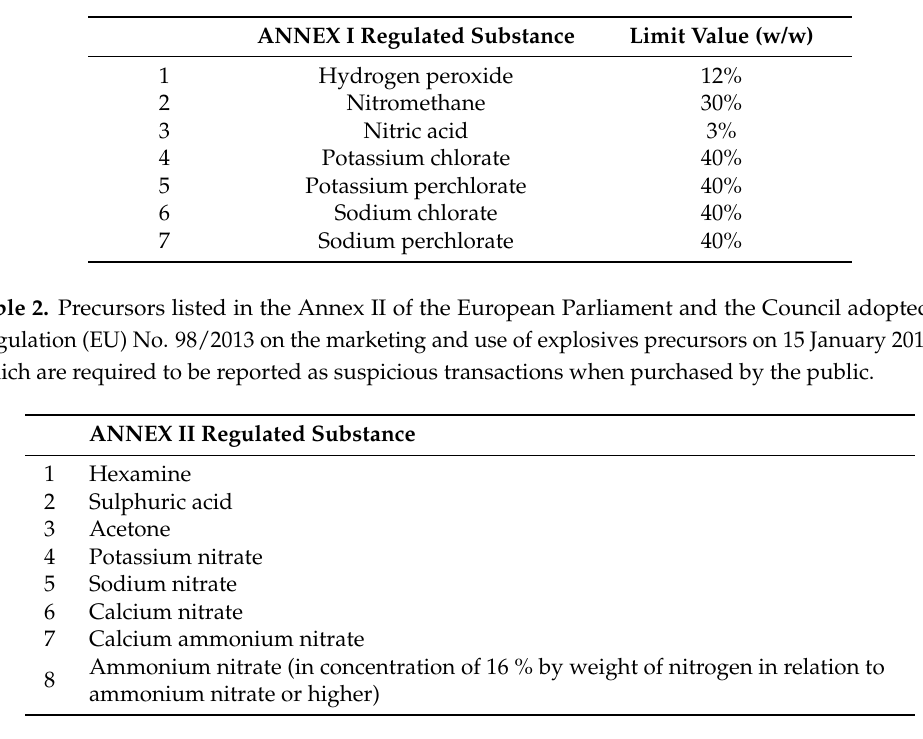
Table 1. Precursors listed in the Annex I of the European Parliament and the Council adopted the Regulation (EU) No. 98/2013 on the marketing and use of explosives precursors on 15 January 2014 [5], which are available to the public only in limited concentration and in Annex II the eight substances that are required to be reported as suspicious transactions when purchased by the public.